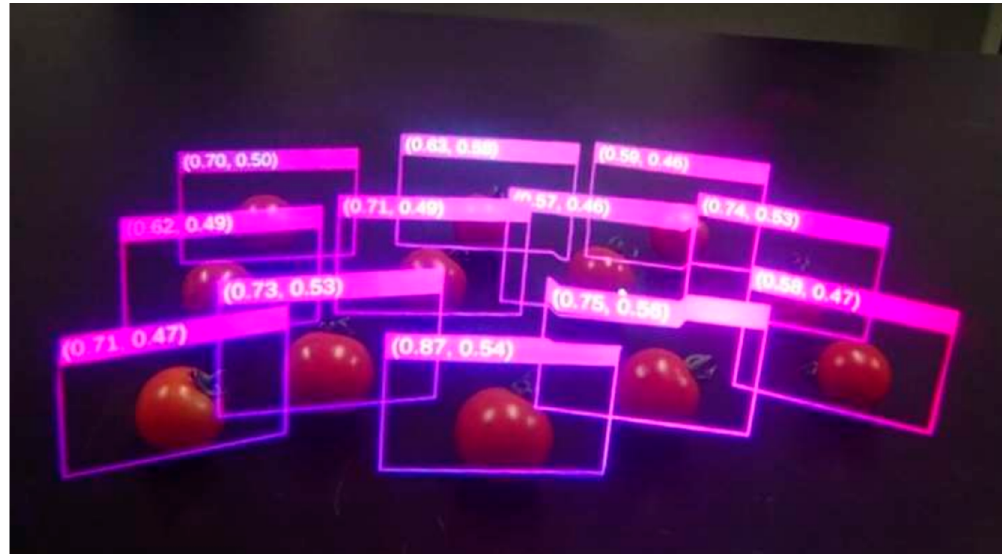
Figure 7. Acidity and sugar content returned by the system. Adapted with permission from [54]. 2022, Institute of Electrical and Electronics Engineers.